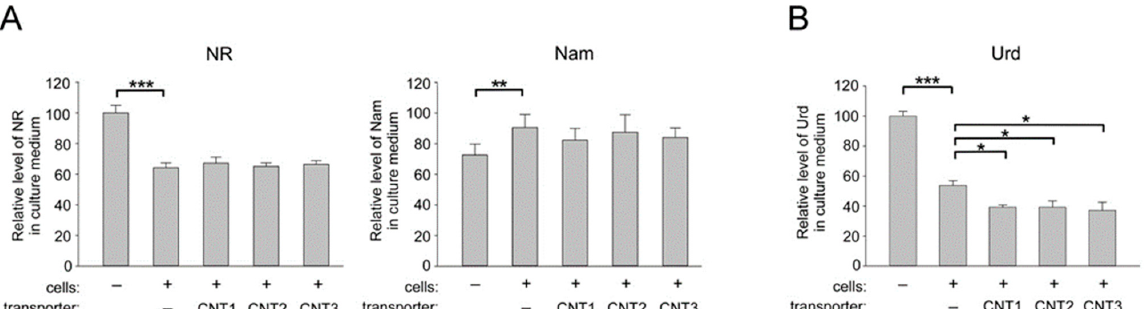
Figure 3. Overexpression of CNT1, CNT2, and CNT3 does not affect the import of NR into HEK293 cells. HEK293 cells cultivated in DMEM were transiently transfected with control (empty) vector or with vectors encoding FLAG-tagged CNT1, 2, or 3 as indicated. Twenty-four hours after transfection, cells were treated with NR (100 µM) ( A ) or with uridine (Urd) (150 µM) ( B ). Twenty-four hours after treatment, culture medium was analyzed by NMR spectroscopy. ( A ) Relative levels of NR and Nam in culture medium are presented. The amount of NR in control culture medium incubated without cells was taken as 100. ( B ) Relative levels of Urd in culture medium are presented. The amount of Urd in control culture medium incubated without cells was taken as 100. Data are presented as mean ± S.D ( n = 3). Statistical analysis of differences between the groups was carried out by a one-way ANOVA with post hoc comparisons using Tukey test. * indicates statistical significance at p < 0.05, ** indicates statistical significance at p < 0.01, *** indicates statistical significance at p <